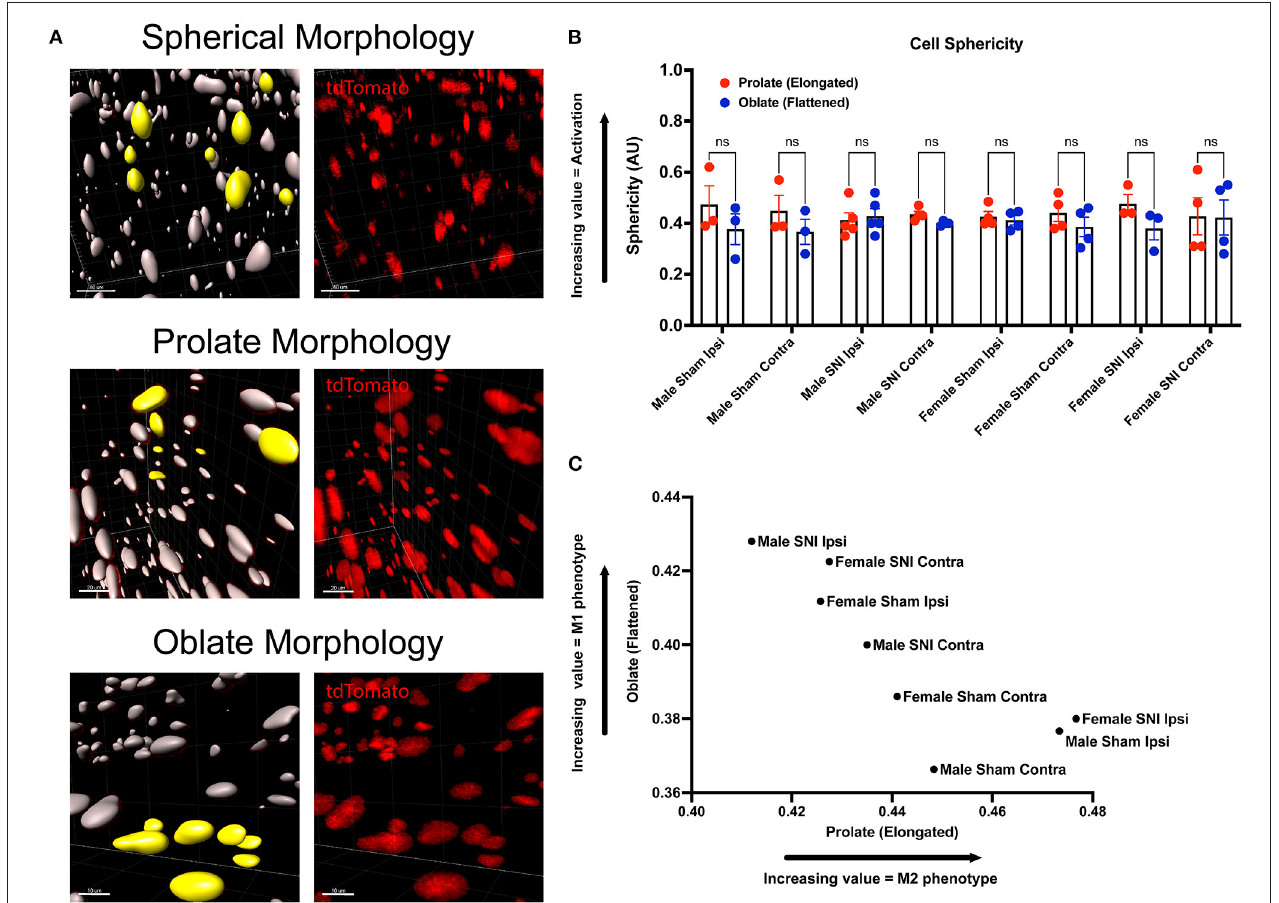
FIGURE 5 | Morphology of LysM tdT + macrophages in the ScN 5 days post-SNI. Male and female LysM tdT + mice had ScNs harvested 5 days post-SNI. Tissues were processed and cleared using ScaleS1 solution for 10–14 days and imaged using 2-photon microscopy. (A) Representative morphology from male and female LysM tdT + (red; 1,100nm) ScNs ( n = 3). (B) Imaris analysis of LysM tdT + cell morphology in male and female ScNs. Cells were analyzed for three morphologic parameters (sphericity, prolate, and oblate) and are displayed comparing oblateness and prolateness with respect to sphericity. (C) Scatter plot of ScN LysM + cell oblateness with respect to prolateness in both male and female injury and control groups. Scale Bar: 100 µ m. IP, Ipsilateral; CO,